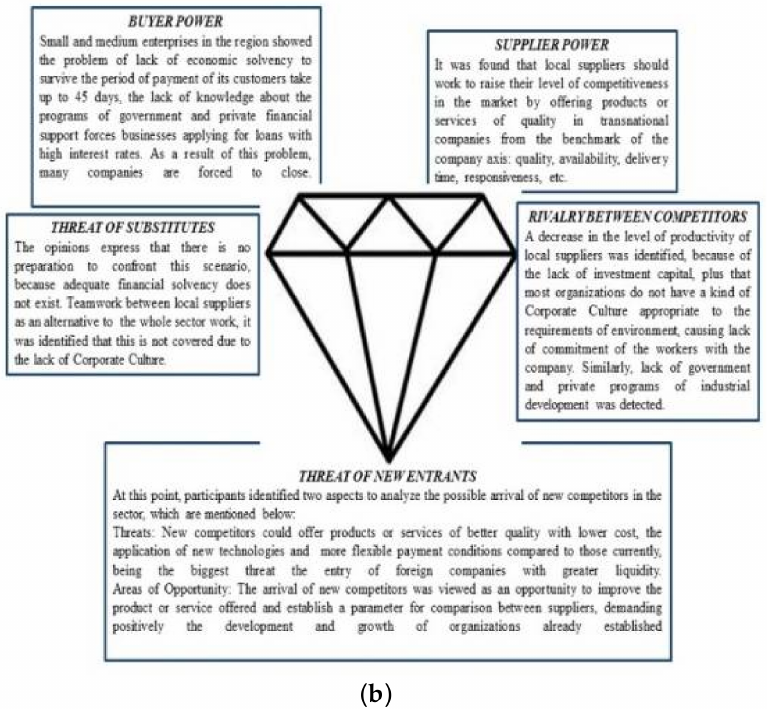
Figure 5. ( a ) Porter’s diamond (2008); ( b ) Author’s elaboration according to Porter’s